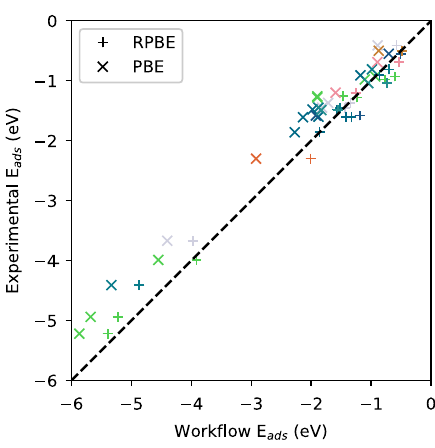
Fig. 2 Experimental benchmarks, in which we compare results from our work fl ow using both the PBE and RPBE functionals